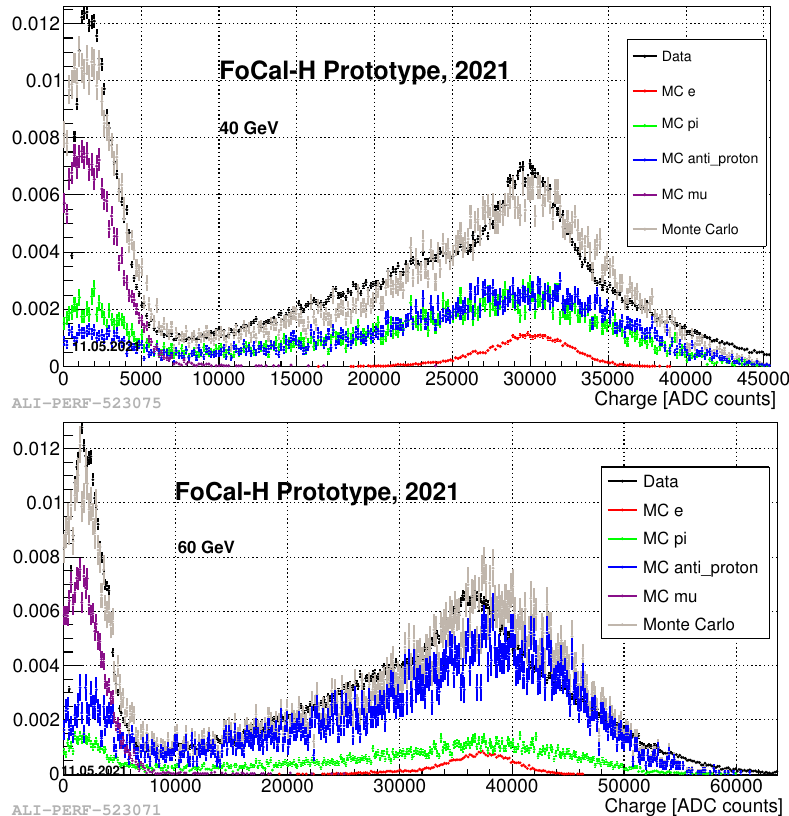
Figure 5. Total charge distribution in data compared with a weighted sum of MC simulated events with 40 GeV ( top ) and 60 GeV ( bottom ) e, π , µ , p.